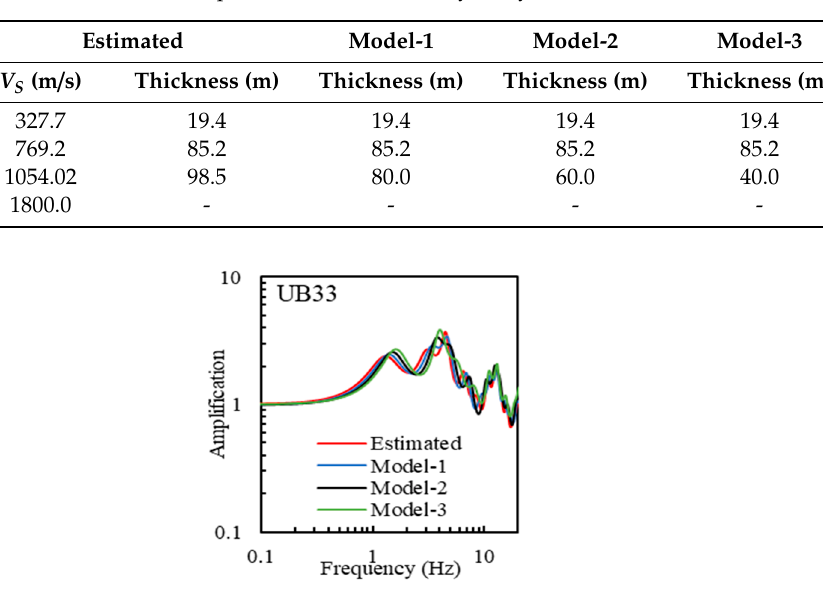
Figure 7. Variations of theoretical site amplification analysis.